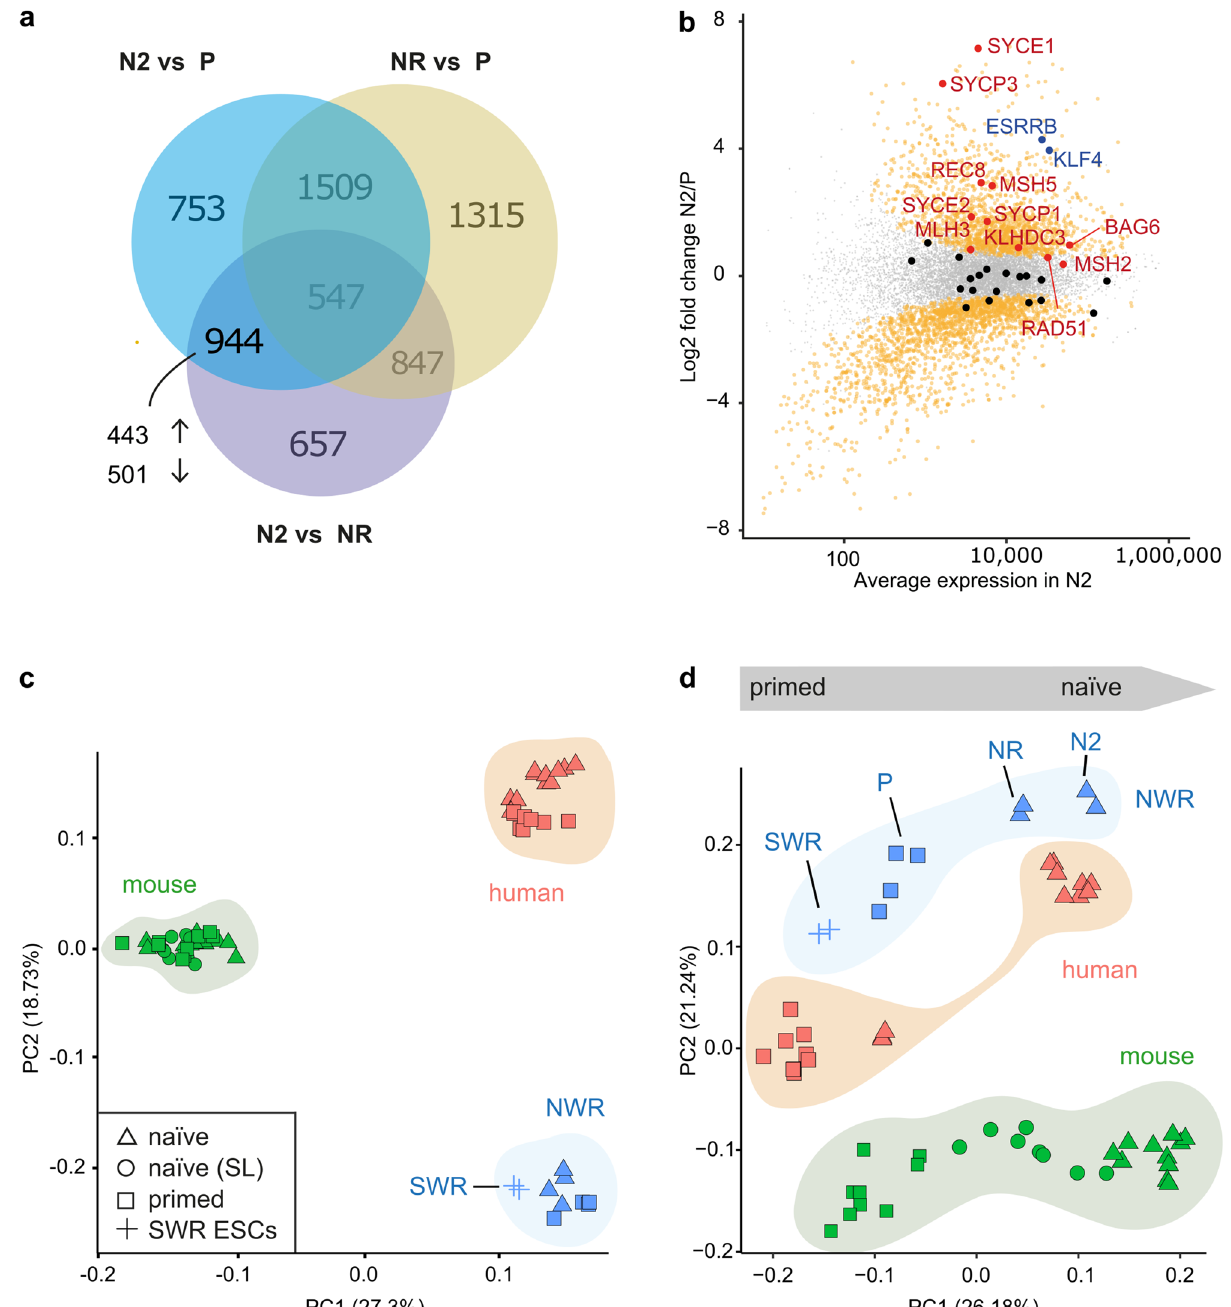
Figure 5. Comparative gene expression analysis. See also Supplementary Fig. S6, Supplementary Tables S1 and S3. (a) Venn-diagram depicting the number of genes, which significantly changed in the analyzed culturing conditions (DESeq2, Foldchange > 1.5, adjusted P value < 0.01). (b) Gene expression changes in naïve N2B27 (N2) as compared to naïve RSeT (NR) and primed mTeSR1 (P) samples. Plotted are log2fold changes N2 vs. P on y axis and the average gene expression in N2 culturing conditions on x axis. Orange: 944 genes, which specifically and significantly changed in N2. Blue: significantly enriched transcription factors known to regulate pluripotency in stem cells. Red: significantly enriched meiosis I related genes (GSEA analysis). Black and grey: meiosis I and all remaining genes, respectively, with no significant expression change. (c,d) Comparative gene expression analysis of NWR iPSCs with human, mouse and SWR ESCs cultured in naïve and primed conditions. Principal component analysis using all expressed genes (c) and a subset of 44 genes, which were detected in all analyzed species, and associated with housekeeping, pluripotency, stemness, naïve and primed state ( (d) , see Supplementary Table S1 for details). P NWR iPSCs primed conditions (mTeSR1), NR, N2 NWR iBCL2-GFP- iPSCs, naïve conditions, RSeT and N2B27 protocols, respectively, naïve (SL) mouse ESCs cultured in serum-LIF